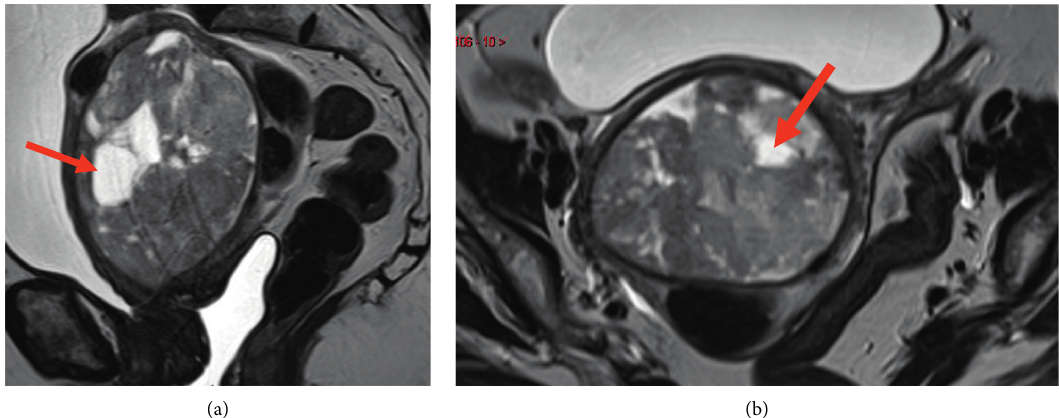
Figure 4: Pelvic MRI of MMMT: (a, b) sagittal (a) and axial (b) T2WI showing a large intrauterine tumor with mixed heterogeneous signal, cystic component showing high signal intensity (arrow).